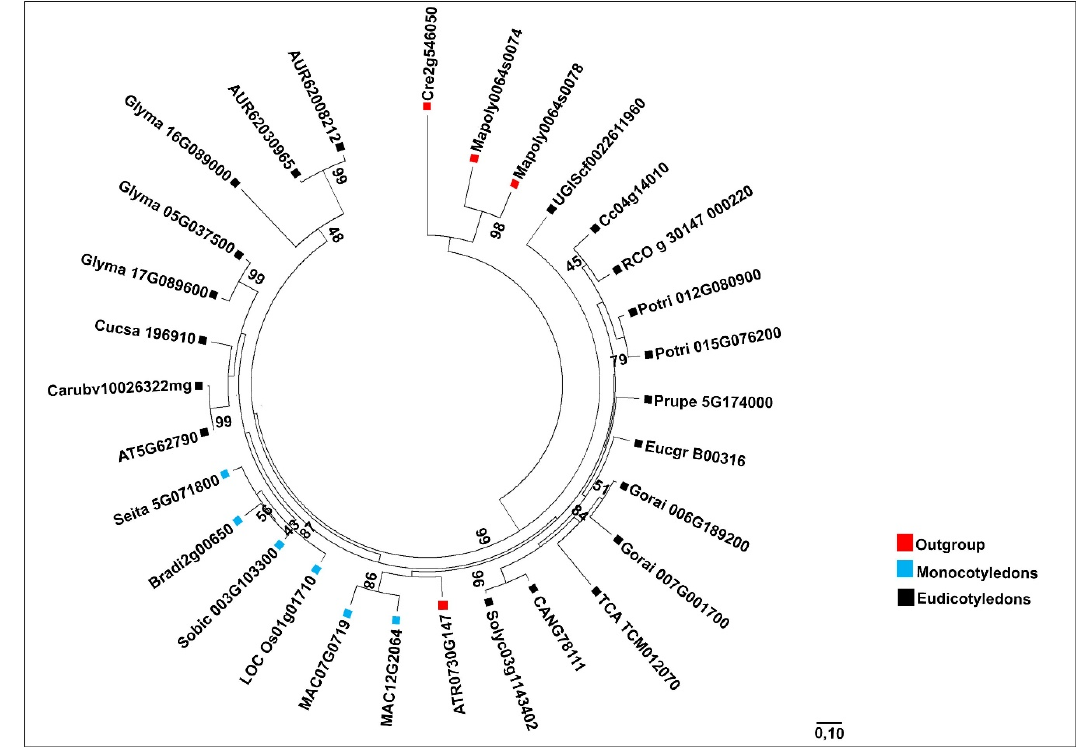
Figure 3. Phylogenetic tree of DXR genes from 24 plant species considered in this study. Outgroup species genes, monocotyledon genes and eudicotyledon genes are indicated using red, blue and black boxes, respectively. Evolutionary history was inferred using 30 DXR amino acid sequences. The tree was drawn using the maximum likelihood method, based on the LG model, with 1000 bootstraps (shown as a percentage). All positions containing missing data and gaps were deleted using Gblocks. There were a total of 374 positions in the final dataset. The evolutionary analysis and tree design were performed using MEGAX software.